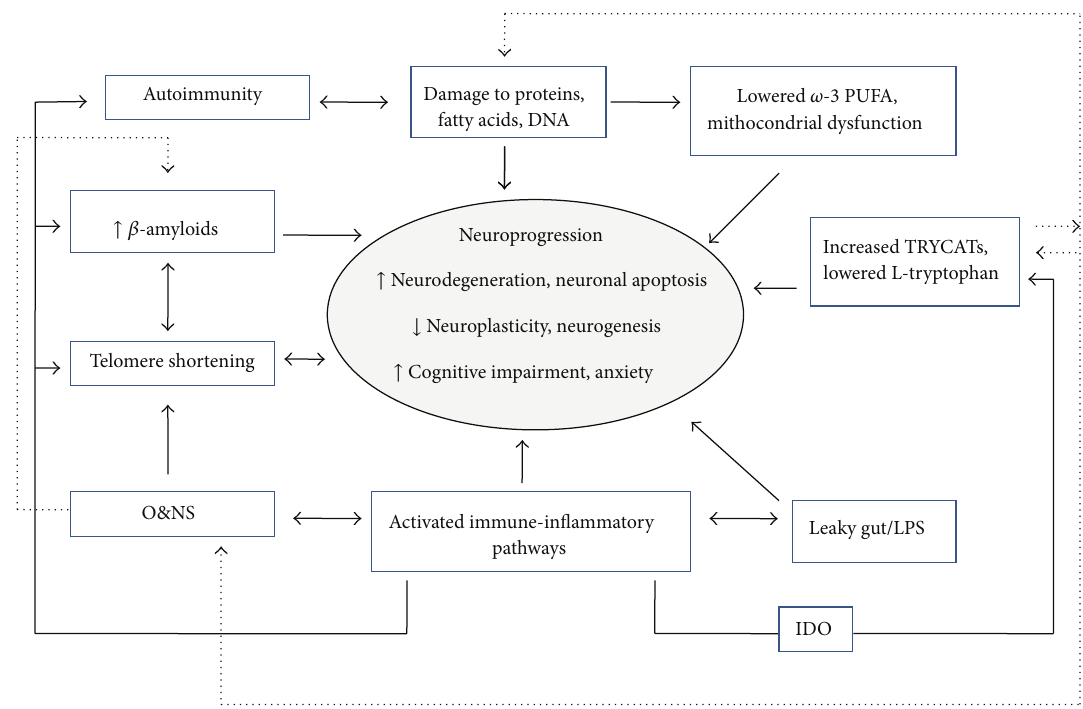
Figure 2: A global model of neuroprogressive changes in aging and anxiety. CMI and inflammatory responses are accompanied by activation of O&NS with production of increased ROS/RNS. ROS/RNS can react with proteins, fatty acids (including 𝜔 -3 PUFAs), and DNA and change their chemical structure which became immunogenic and produce an autoimmune response. Both O&NS and CMI inflammation are implicated in beta-amyloid formation and telomeres shortening. Moreover, increased O&NS impairs mitochondrial function with further production of ROS and macromolecular damage. PICs activate IDO which causes depletion of tryptophan/5-HT and the synthesis of tryptophan catabolites (TRYCATs). Some of these TRYCATs (kynurenine and quinolinic acid) are anxiogenic and neurotoxic. The lipopolysaccharide (LPS), caused by bacterial translocation from the gut, may aggravate existing inflammation and O&NS or trigger a primary inflammatory response. LPS and lowered 𝜔 3 are associated with decreased neurogenesis. CMI: cell-mediated immune; PICs: proinflammatory cytokines; IL-1 𝛽 : interleukin-1 𝛽 ; IL-6: interleukin-6; TNF- 𝛼 : tumor necrosis factor- 𝛼 ; IFN- 𝛾 : interferon-gamma; O&NS: oxidative and nitrosative stress; ROS: reactive oxygen species; RNS: reactive nitrogen species; IDO: indoleamine 2,3-dioxygenase; TRYCATs: L-tryptophan catabolites; LPS: lipopolysaccharide (a component of the outer membrane of Gram-negative bacteria); 𝜔 -3 PUFAs: omega-3 polyunsaturated fatty